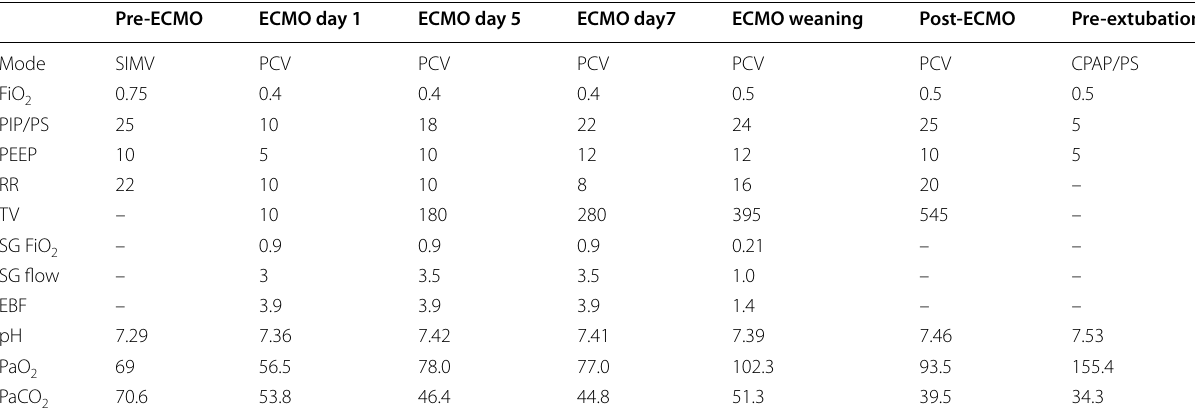
Table 1 Ventilator parameters and arterial blood gas analysis